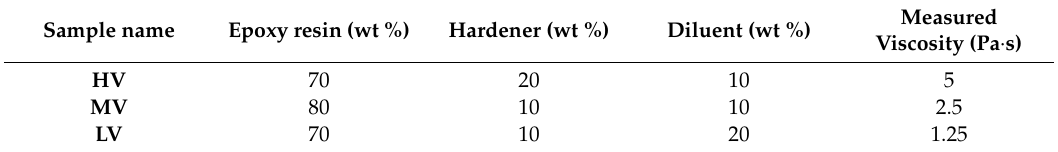
Table 1. Proportions of impregnation solution.